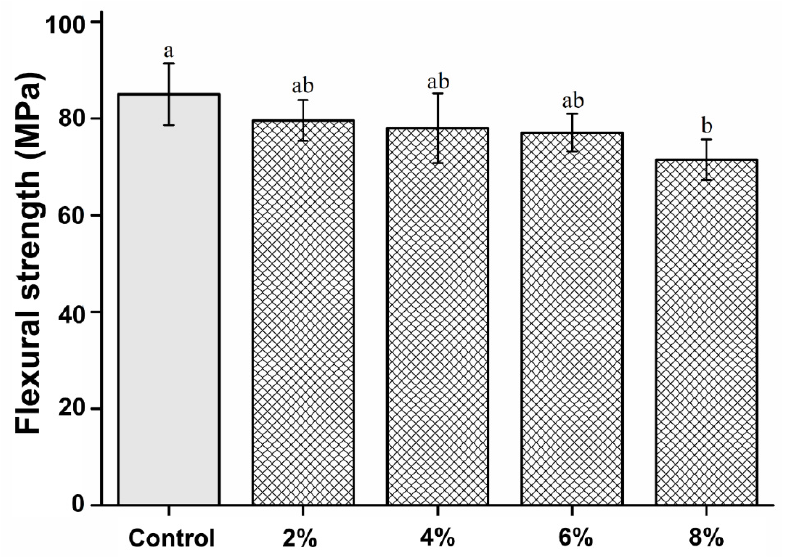
Figure 4. Comparison of the flexural strength between the groups. Different letters indicate a statis- tically significant difference (P < 0.05). statistically significant difference (P <